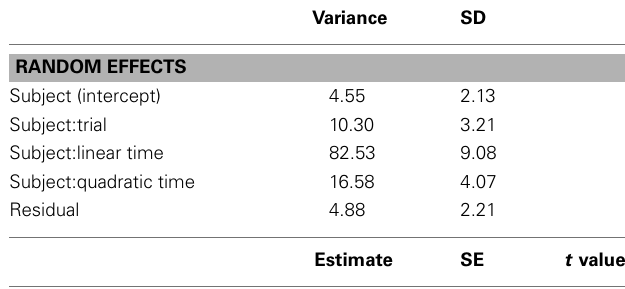
TableA1 | Growth curve model results forTrials 9 and 10 for the full sample.